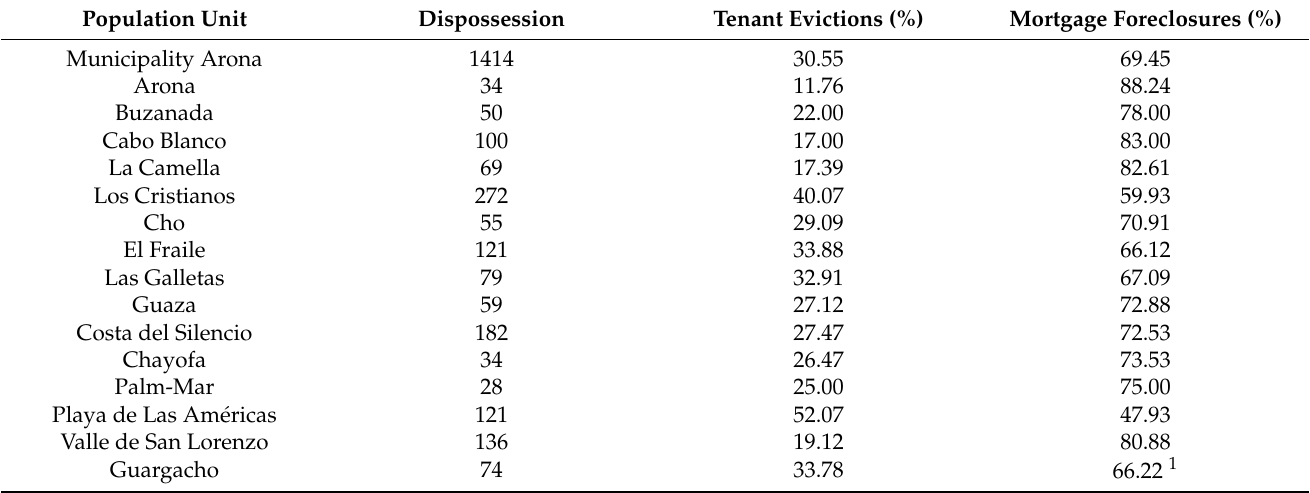
Figure 2. Evolution of dispossession in Arona (2001–2015). Database ATLANTE. Own elaboration. Table 2. Real estate dispossession in the population units of Arona 2001–2015.